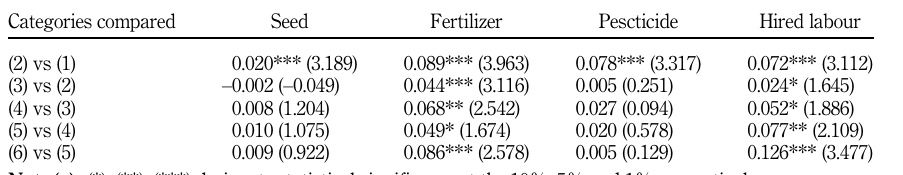
Table V. Impact of credit rationing on capital allocated to